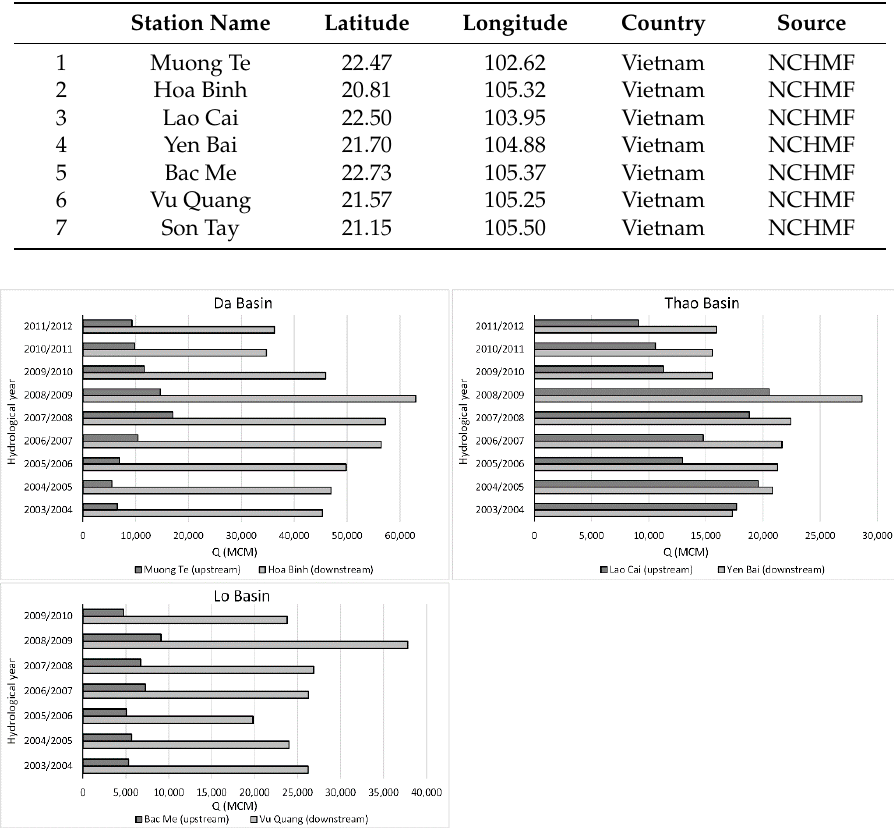
Figure A5. Runoff in million cubic meters (MCM) generated per hydrological year in each of the subbasins, according to streamflow (Q) records.